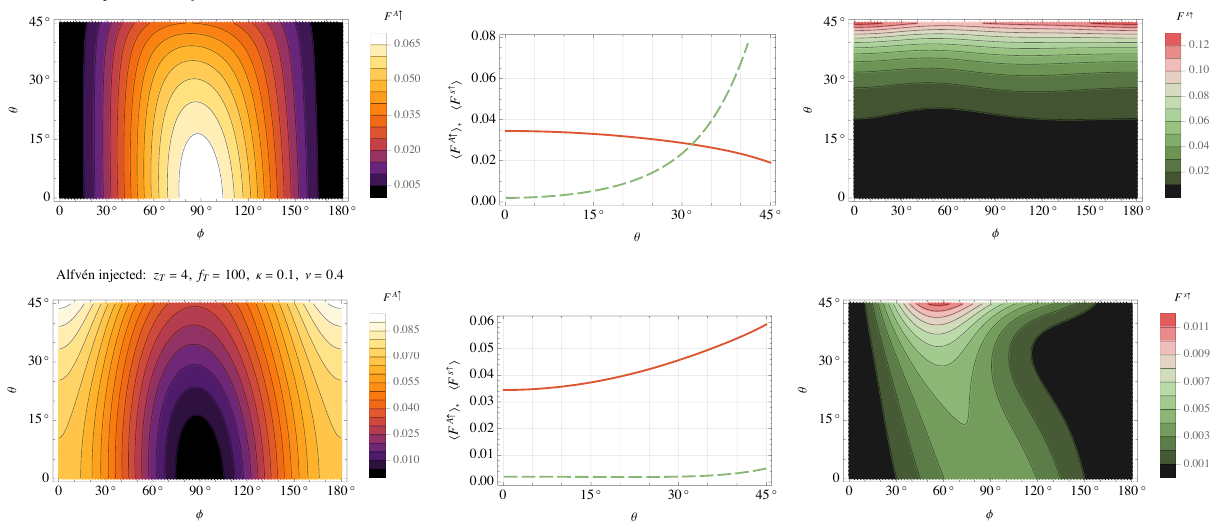
Figure 9. Top Alfvén and slow wave fluxes as functions of φ and θ , and averaged over φ , as in Figure 6, but for z T = 4 and ν = 0.4. There is no injected fast wave, as ν = 0.4 is below the acoustic